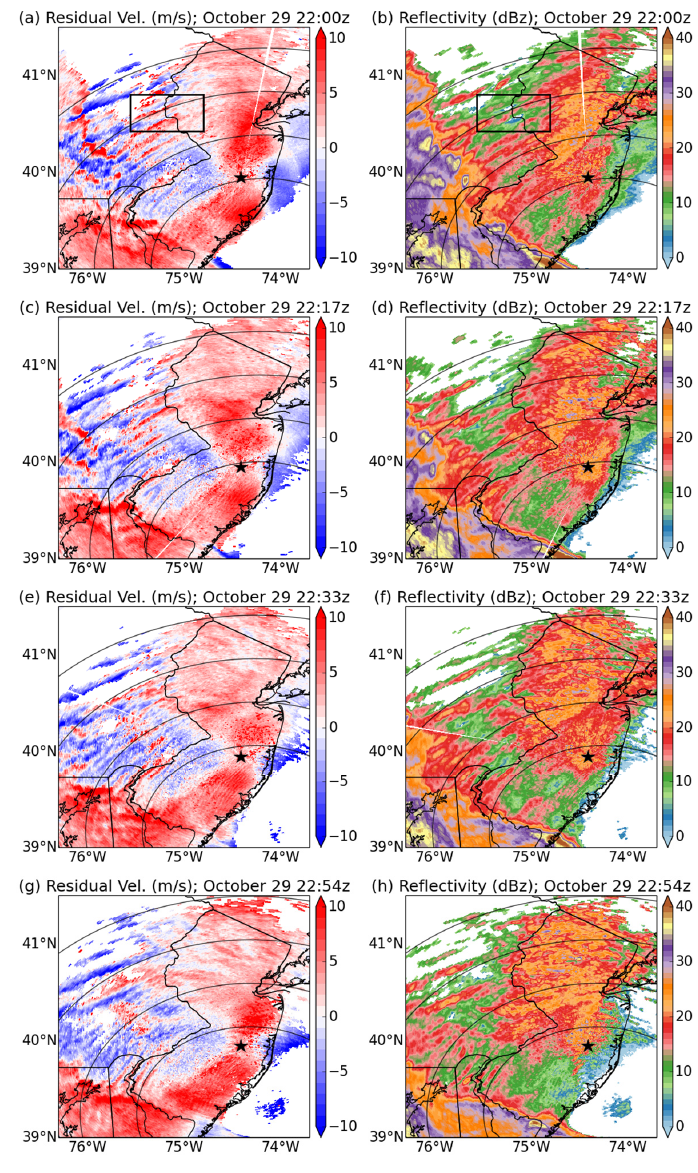
Figure 2. Roll signatures in observations during Sandy’s landfall period obtained by WSR-88D radar located at Fort Dix, NJ. All radar scans are at an elevation angle of 0.5 degree, which is the lowest angle available. Radar location is indicated by the black star. Distance from Sandy’s center is shown as contour lines (100 to 250 km with an interval of 50 km). Figure ( a , c , e , g ) shows radar residual velocity at 2200, 2217, 2233, and 2254 UTC 29 October 2012, respectively. Figure ( b , d , f , h ) shows reflectivity at 2200, 2217, 2233, and 2254 UTC, respectively. The color bar for reflectivity is chosen to emphasize roll features. The height above ground of the measured wind component increases with distance from the radar site, from about 0.7 km height near the roll features in southwestern New Jersey to about 3.9 km at the northwestern edge of the roll features over eastern